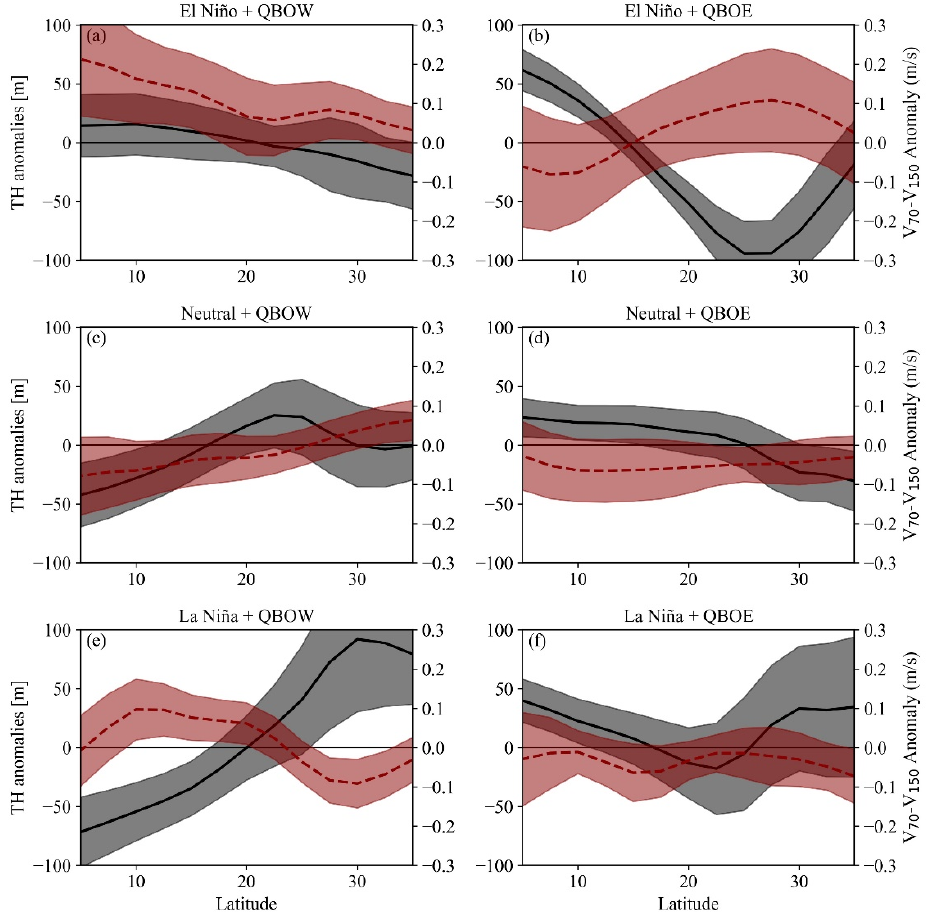
Figure 7. Mean NCEP-NCAR tropopause height anomalies (solid black line and left vertical axis) with V70–V150 anomalies (dashed red line and right vertical axis) during the season JJASON for the years classified as ENSO and QBO phases: ( a ) El Niño-QBOW, ( b ) El Niño-QBOE, ( c ) Neutral-QBOW, ( d ) Neutral-QBOE, ( e ) La Niña-QBOW, and ( f ) La Niña-QBOE during the 1953–2020 period.